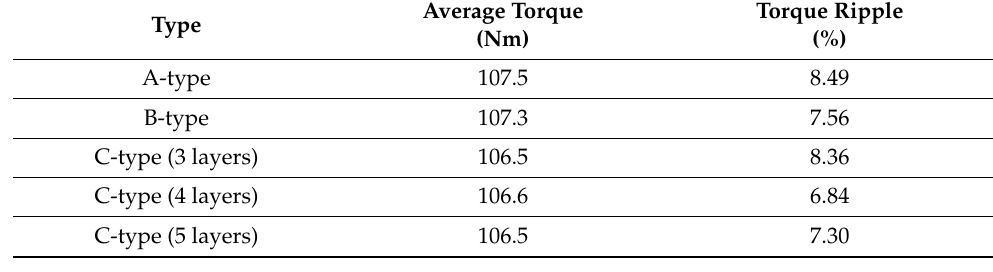
Table 3. Comparison of torque characteristics at 1350 rpm with the wedge skew.